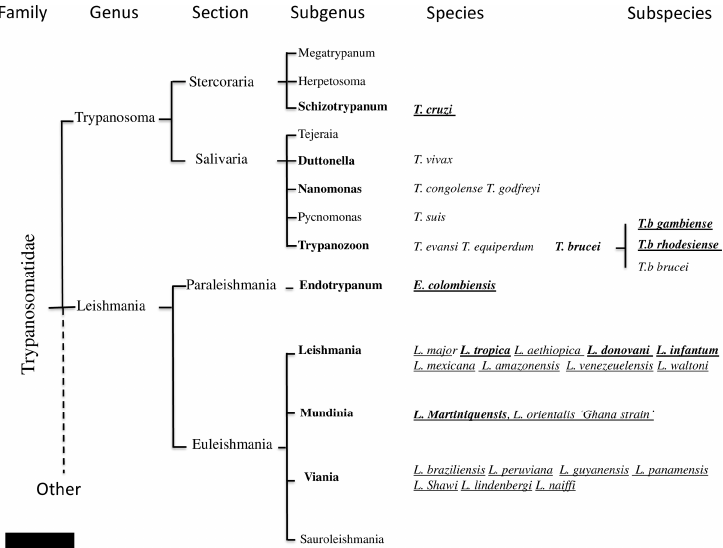
Figure 1. Classification of human and animal pathogenic trypanosomatids. Human pathogenic species are underlined, and pathogens causing systemic infection are in bold.